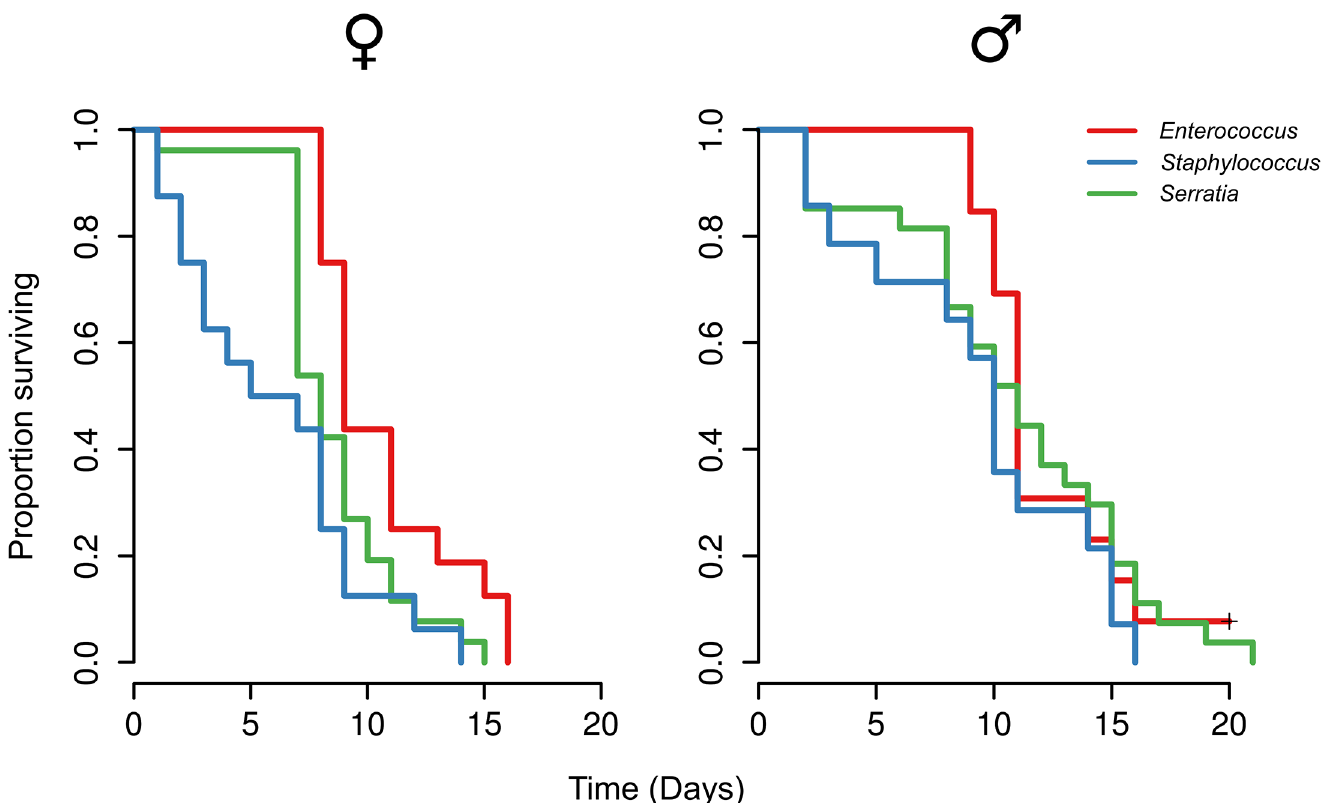
Fig 2. Survival of adults with experimentally defined gut microbiota. Larvae were re-inoculated with a defined microbiota comprising either wild-type Enterococcus mundtii , Staphylococcus sp. or Serratia sp. based on previous results (Fig 1).